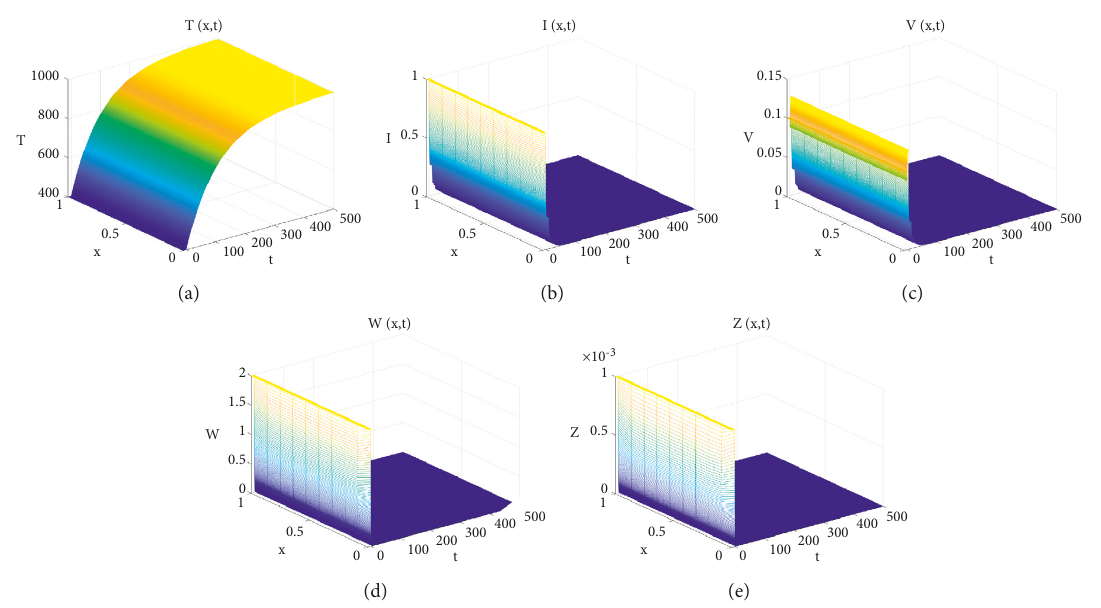
Figure 1: Taking β ( 1000 , 0 , 0 , 0 , 0 ) is asymptotically stable.